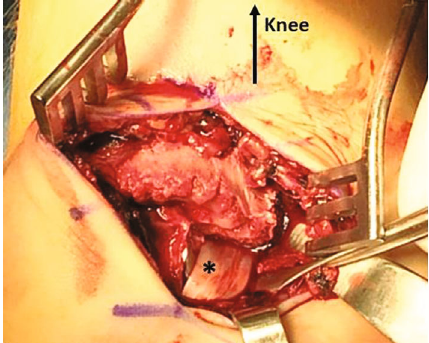
Figure 3: Intraoperative photo showing interposition of tibialis posterior tendon ( ∗ ) at the fracture site between the metaphysis and epiphysis.